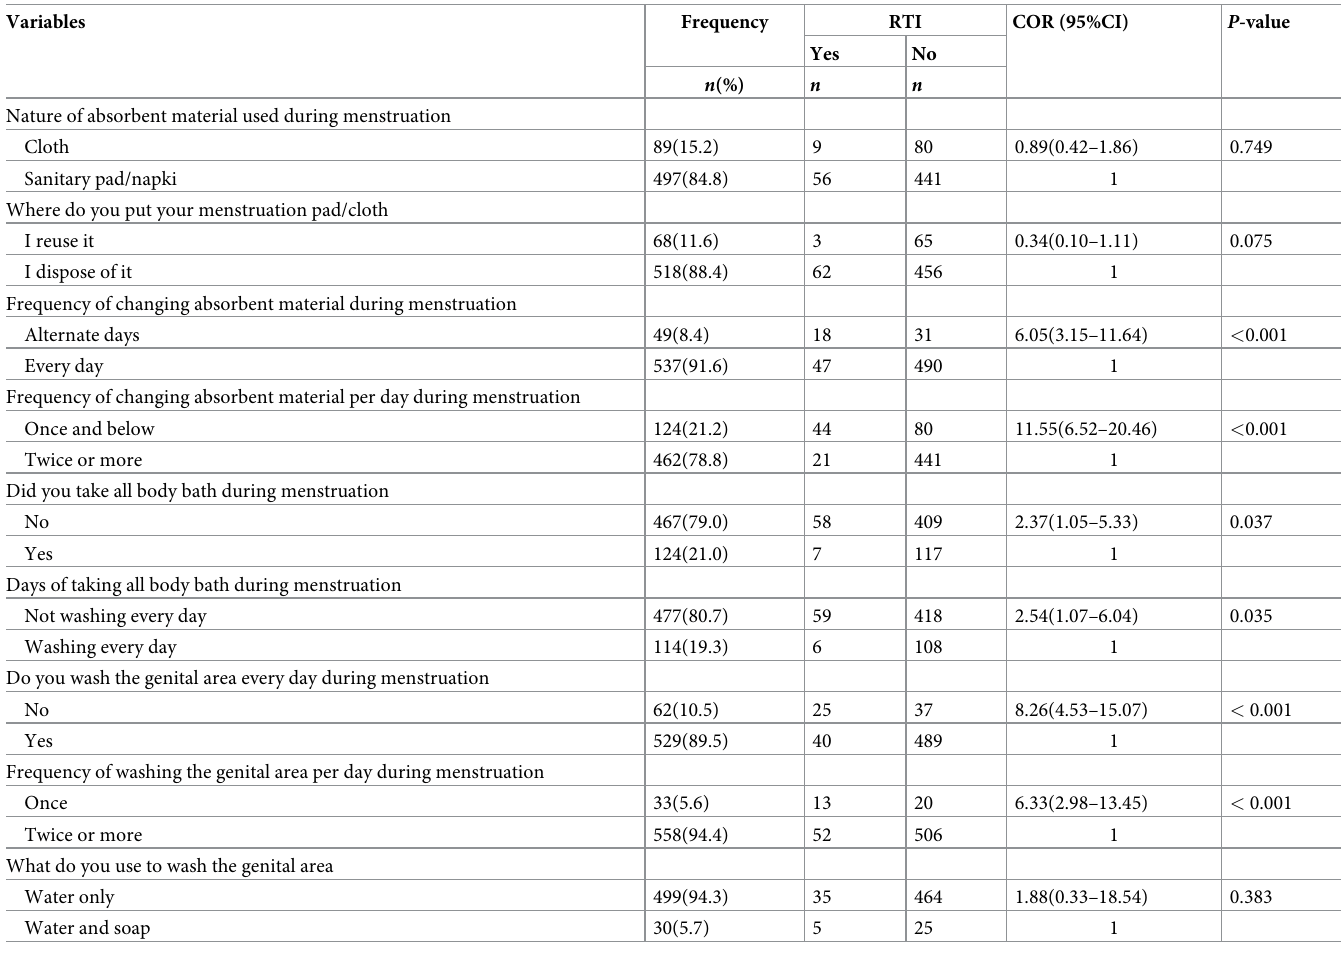
Table 5. Menstrual hygiene management (MHM) practices among reproductive age women in Dessie City, Ethiopia, January to March